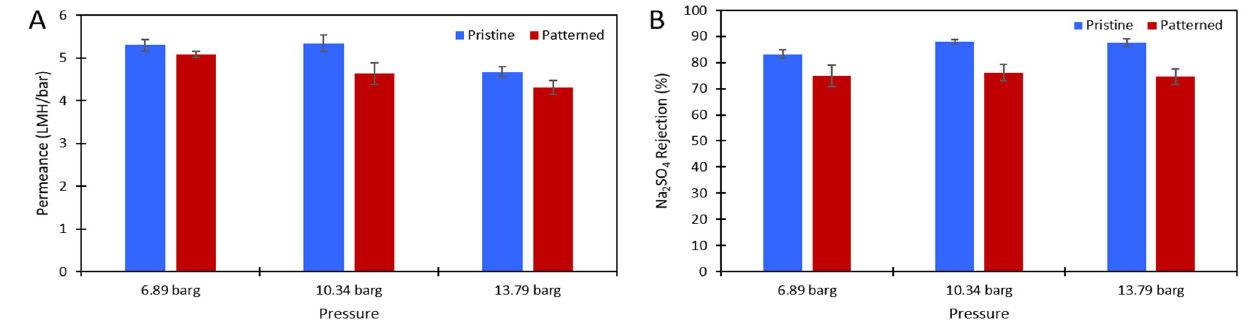
Figure 5. ( A ) The solution permeance (LMH/bar) data and ( B ) Na 2 SO 4 rejection data for the 10,000 ppm Na 2 SO 4 feed. Blue is the pristine membrane, and red is the patterned membrane. The error bars represent one standard deviation among at least three membrane samples.